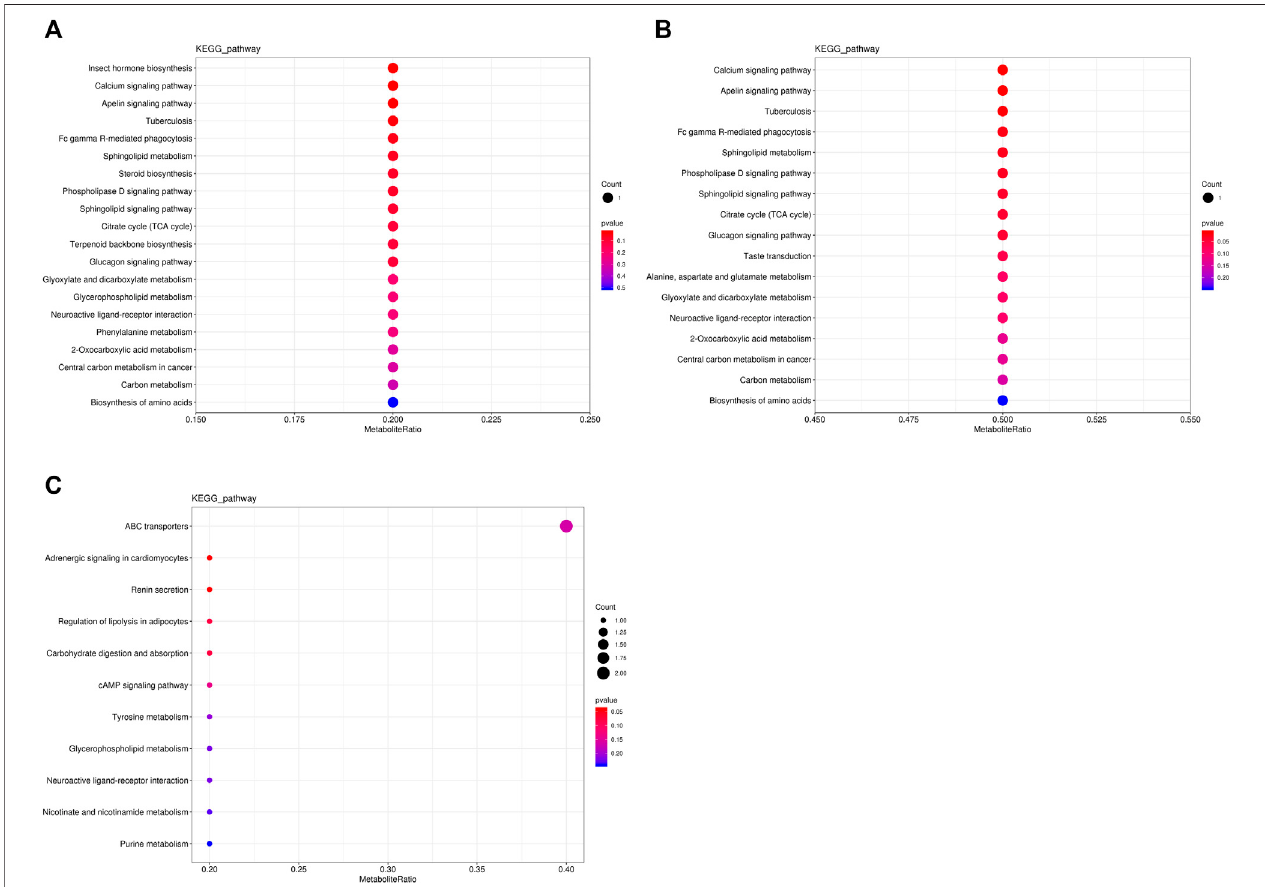
FIGURE 4 | KEGG pathway-enriched dot plots of differentially abundant metabolites. (A) , NT vs CS2; (B) , NT vs CS6; and (C) , NT vs CS12.